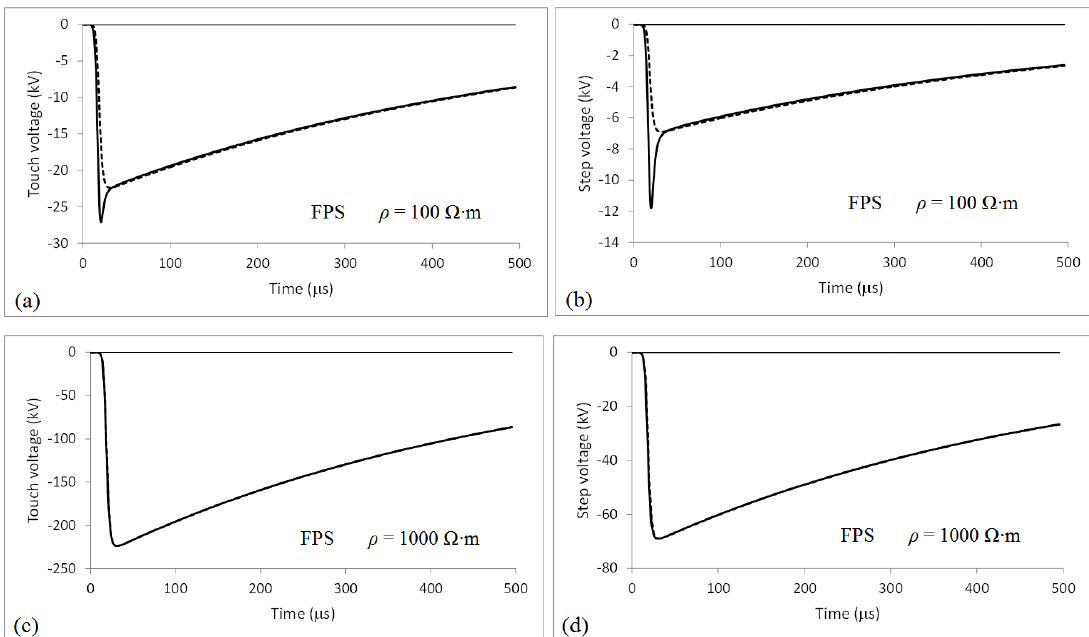
Figure 6. Touch voltage (TV) and step voltage (SV) for first positive stroke (FPS). Solid line: transient Figure 6 . Touch voltage (TV) and step voltage (SV) for first positive stroke (FPS). Solid line: transient response calculated from Equation (4); Dashed line: DC response calculated from Equation (13). ( a ) TV response calculated from Equation (4); Dashed line: DC response calculated from Equation (13). and ρ = 100 Ω · m; ( b ) SV and ρ = 100 Ω · m; ( c ) TV and ρ = 1000 Ω · m; ( d ) SV and ρ = 1000 Ω ·